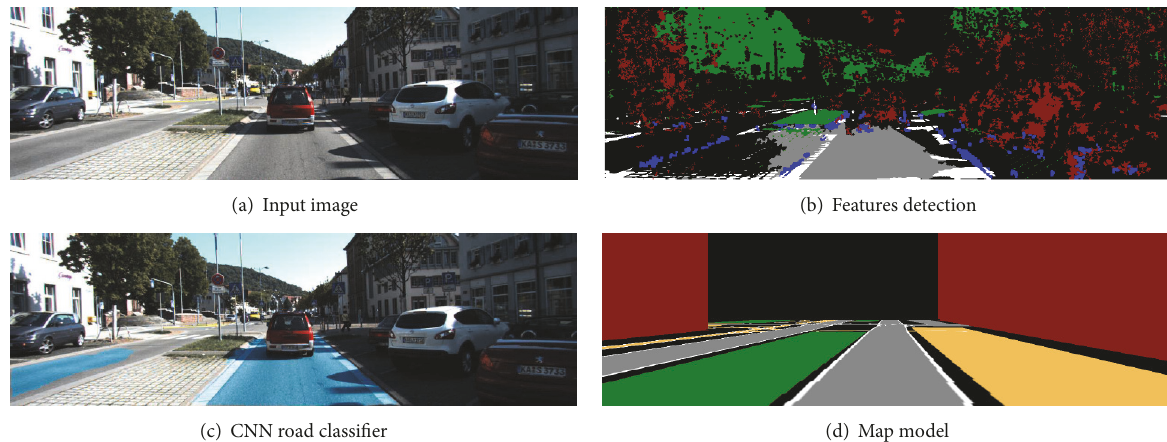
Figure 13: Results in a scene with parking slots on the right and vegetation on the left. Even with a coarse detection of the road (Figure 13(b)), the map model fits well to the scene and add high-level information to the system.